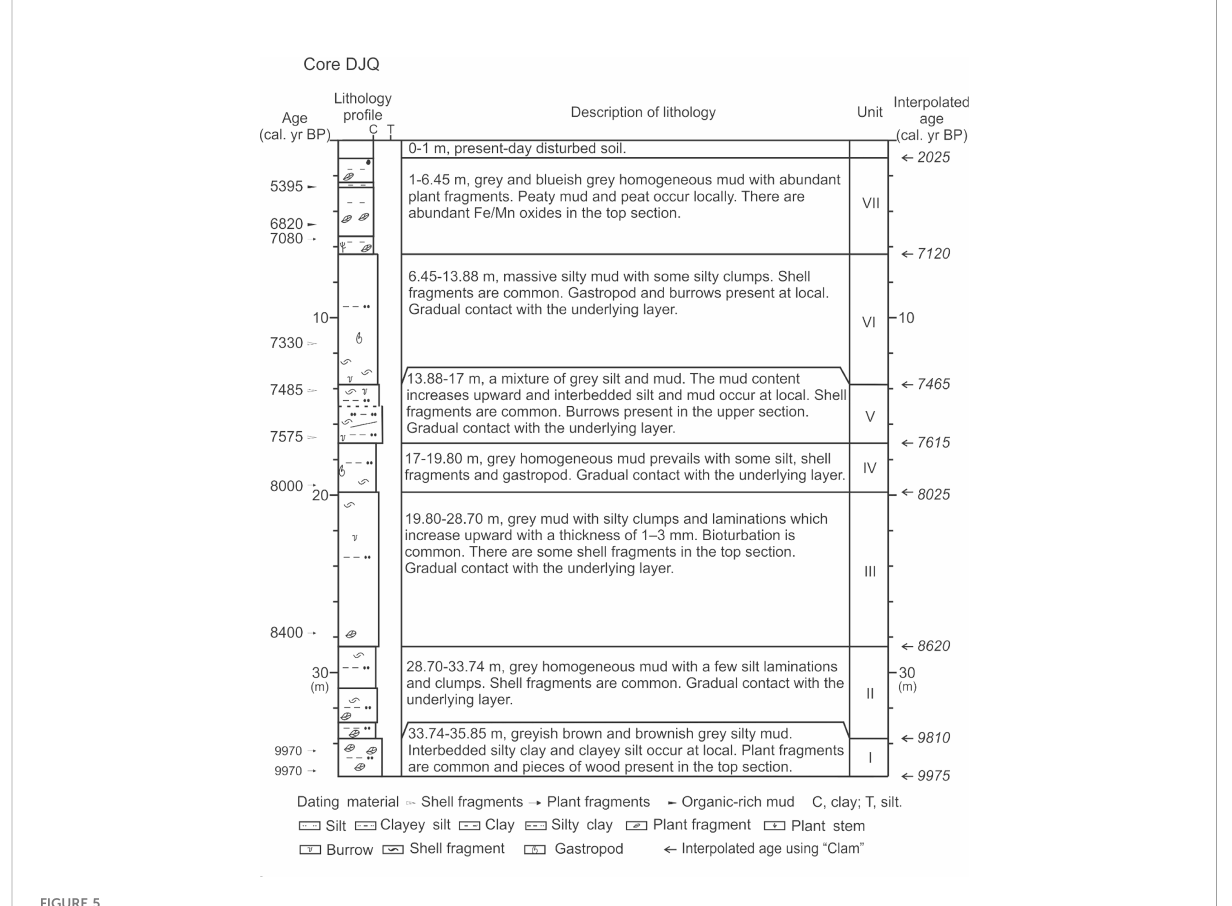
FIGURE 5 Sedimentary pro fi le of core XY, including lithology description and calibrated radiocarbon ages. Interpolated median ages by “ Clam ” at the boundaries of each unit are indicated on the